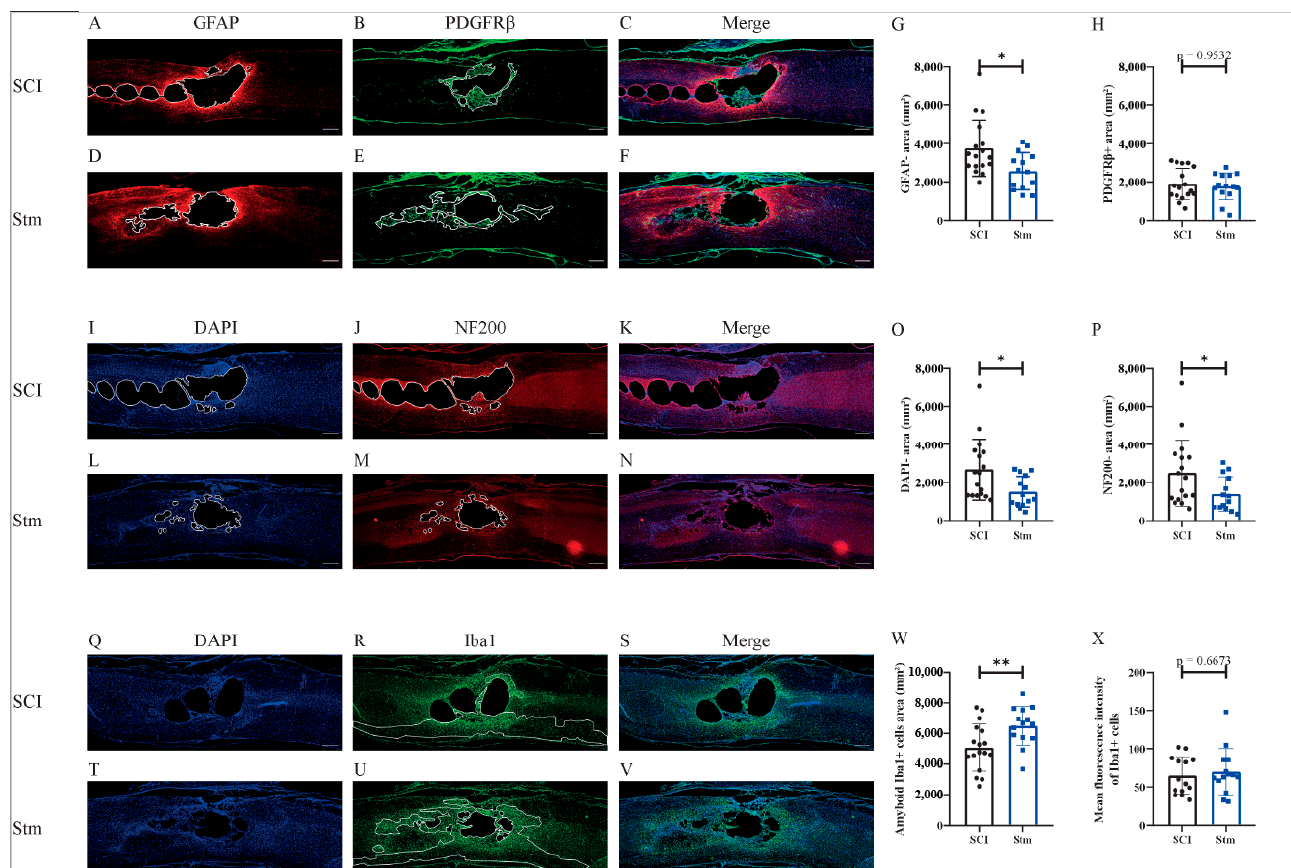
Figure 9. rTSMS treatment enhances tissue repair after contusive SCI in rats 60 days after SCI. At day 60, immunohistological analyses were performed. ( A – F , I – N , Q – V ) Representative pictures of sagittal spinal cord sections of ( A – C , I – K , Q – S ) SCI and ( D – F , L – N , T – V ) Stm (rTSMS treated) animals. Sections were stained with ( A , D ) GFAP, ( B , E ) PDGFR β , ( I , L , Q , T ) DAPI, ( J , M ) NF200 and ( R , U ) Iba1. ( G ) Quantification of astrocytic-negative area (GFAP-). ( H ) Quantification of fibrosis-positive area (PDGFR β +). ( O ) Quantification of DAPI-negative area (DAPI-). ( P ) Quantification of NF200-negative area (NF200-). ( W ) Quantification of Iba1-amyboid-positive cells’ area (Iba1+) and ( X ) quantification of Iba1+ mean fluorescence intensity. Scale bars are 200 μ m; n = 17 animals per SCI group and n = 14 per Stm group. Quantifications are expressed as average ± SD. Statistical evaluations are based on the Mann–Whitney test (* = p < 0.05 and ** = p < 0.01).